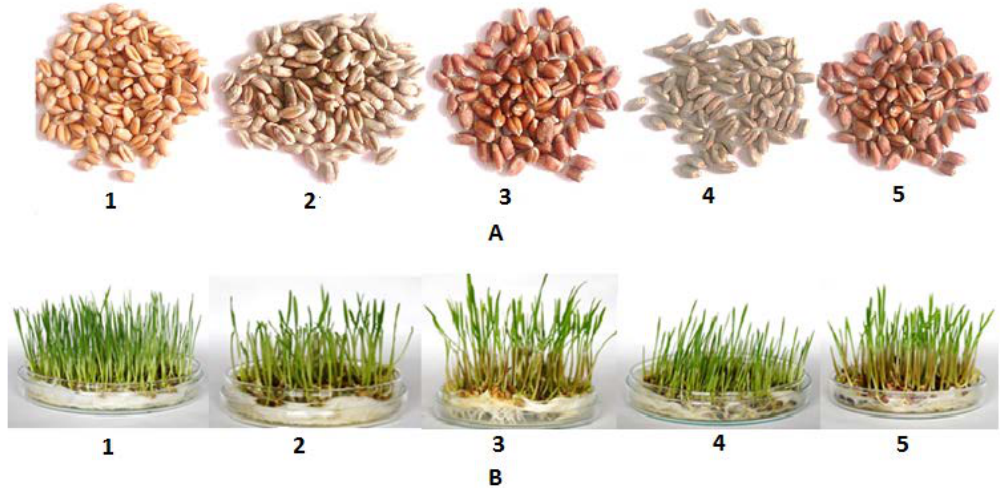
Figure 6. Experimental differently pigmented wheat grains ( A ) and sprouts ( B ). 1—Citrus yellow, 2—KM 53-14 Blue, 3—KM 178-14 purple, 4—Skorpion Blue aleurone, 5—PS Karkulka purple.